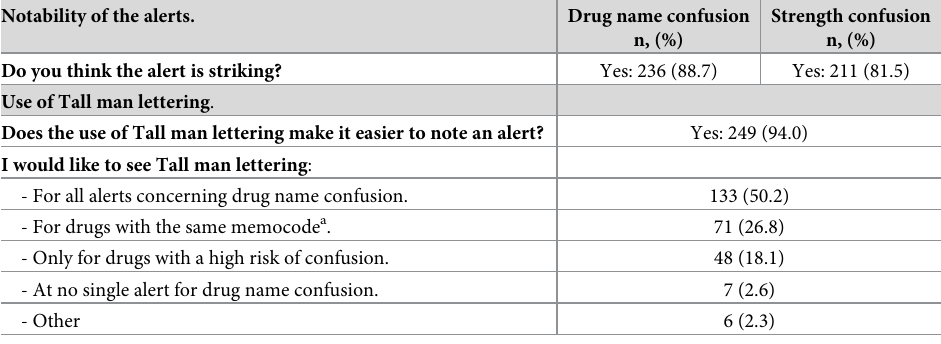
Table 4. Pharmacist and technician’s attitude towards the alert for drug name and strength confusion and the use of Tall man lettering. Notability of the